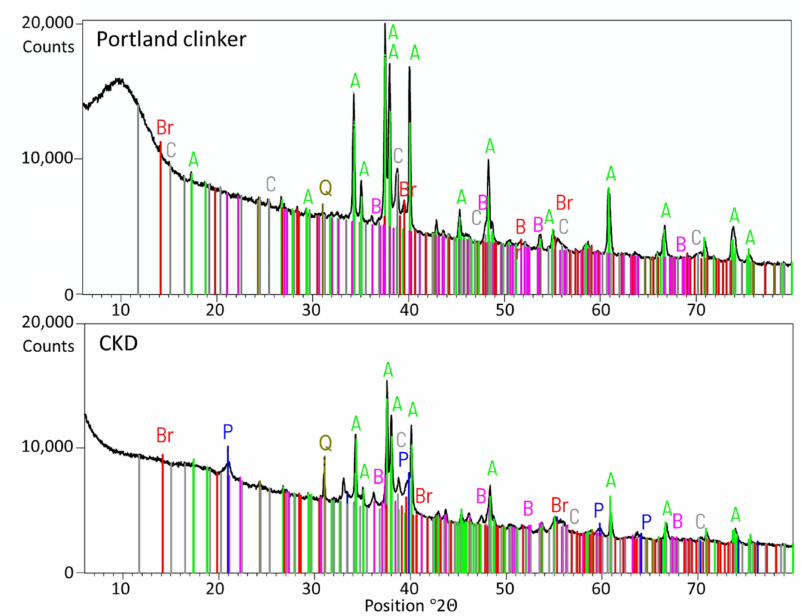
Figure 4. XRD analysis of CKD and the Portland clinker from which production it was obtained. A— tricalcium silicate; B—dicalcium silicate; C—tricalcium aluminate; Br—tetracalcium aluminoferrite; Q—quartz;